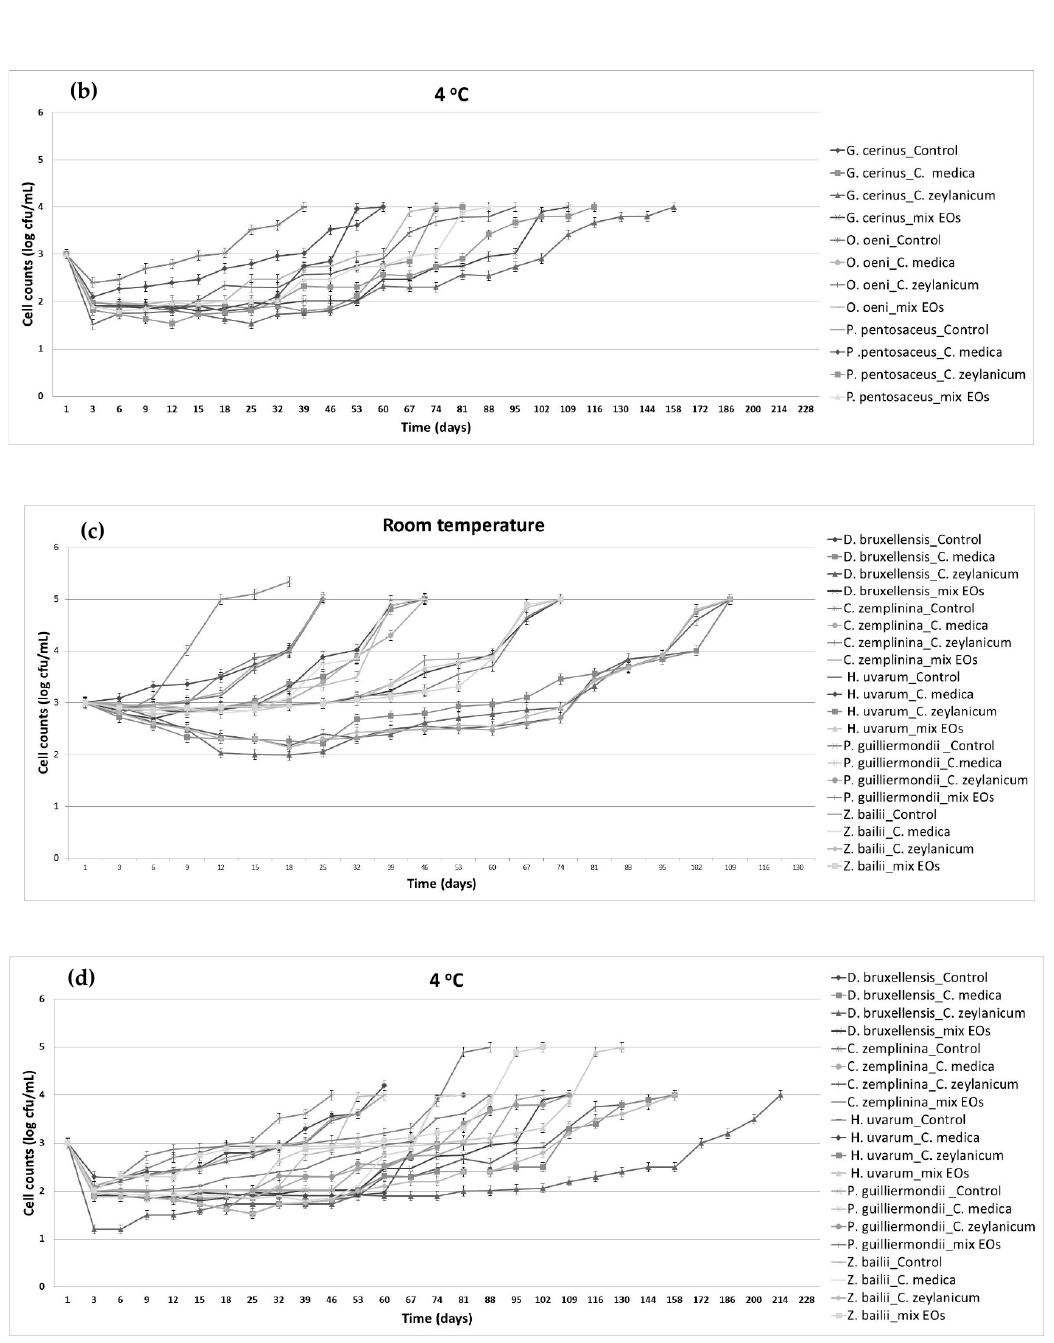
Figure 2. Effect of Citrus medica and Cinnamomum zeylanicum EOs on microbial growth in deliberately spiked low alcohol wines (~6 % vol) during storage at room temperature (18–20 °C) and at 4 °C. Wines were supplemented with either C. medica or C. zeylanicum EO (0.010%) or their mixture (0.005% of each oil). Wine with no EO was used as control. Gluconobacter cerinus Oenococcus oeni and Pediococcus pentosaceus counts at room temperature ( a ) or at 4 °C ( b ). Dekkera bruxellensis , Candida zemplinina , Hanseniaspora uvarum , Pichia guillermndii and Zygosaccharomyces bailii counts at room temperature ( c ) or at 4 °C ( d ).